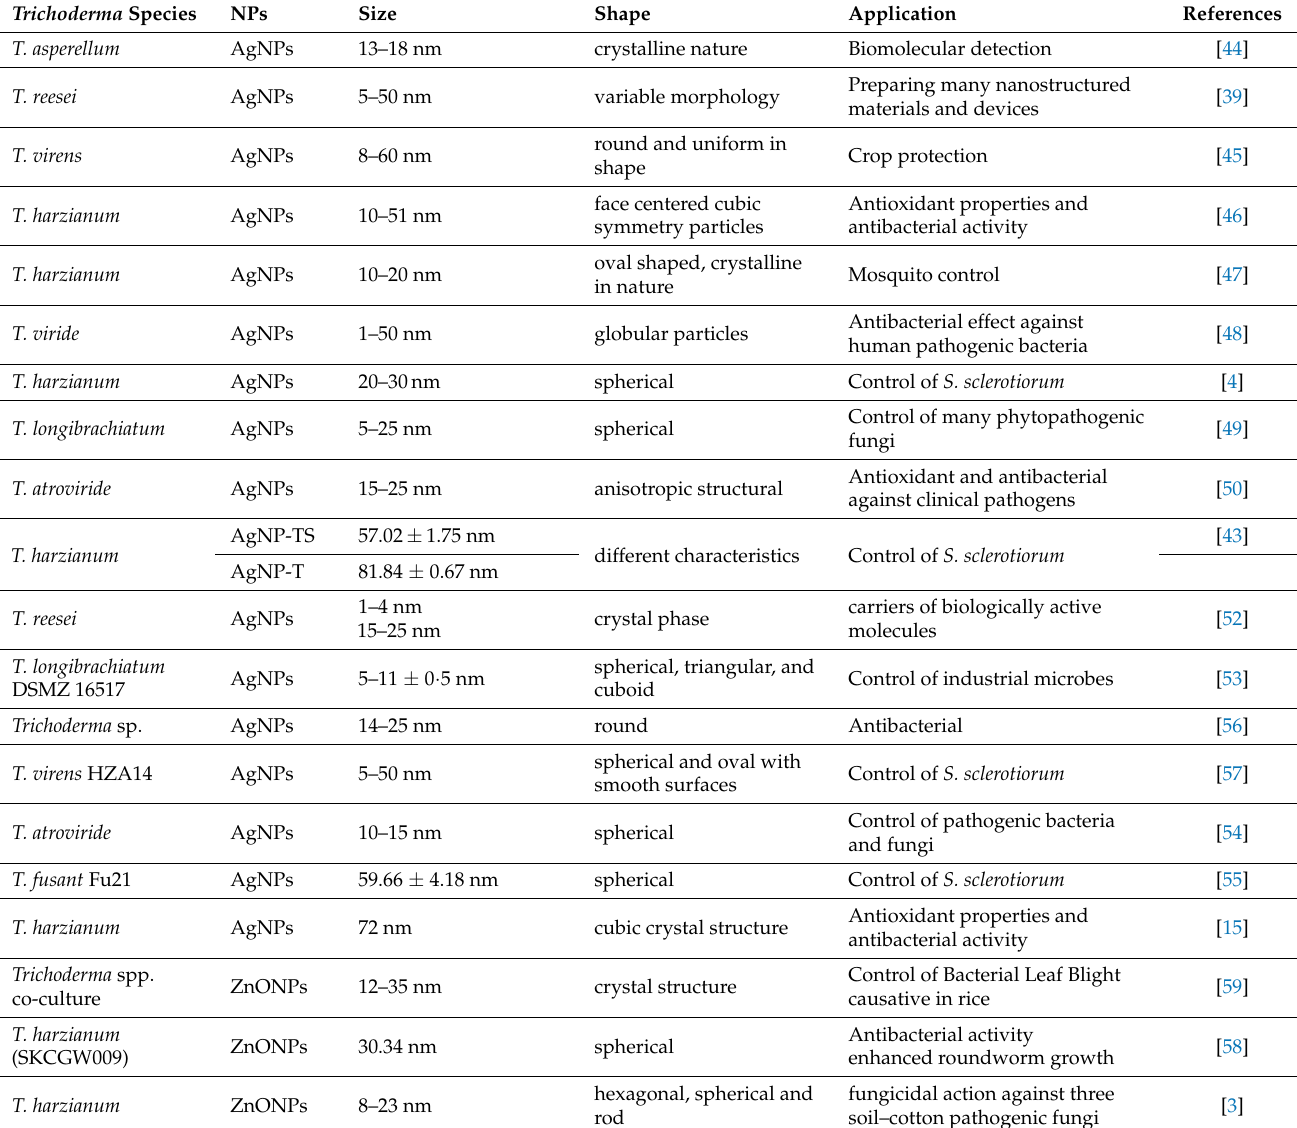
Table 1. Trichoderma species employed for green synthesis metal